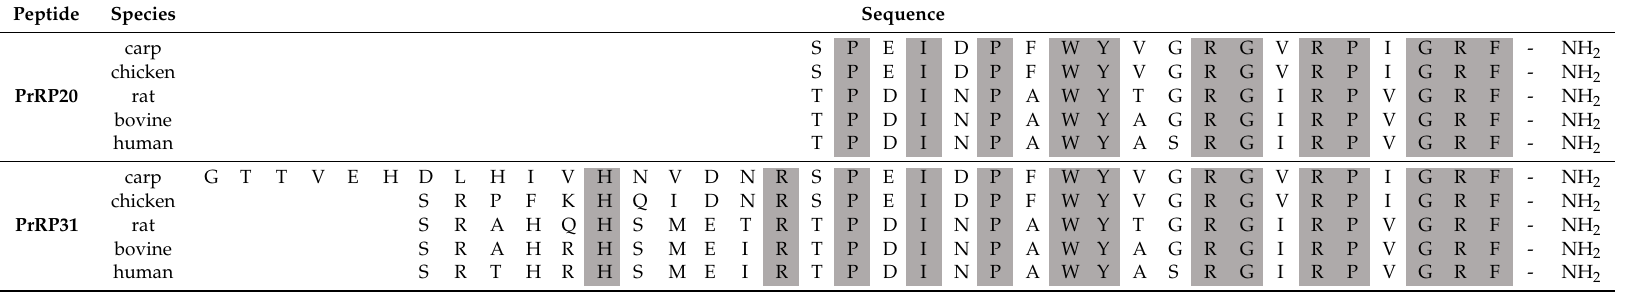
Table 1. Sequences of prolactin-releasing peptide (PrRP): PrRP20 and PrRP31 in di ff erent animal species